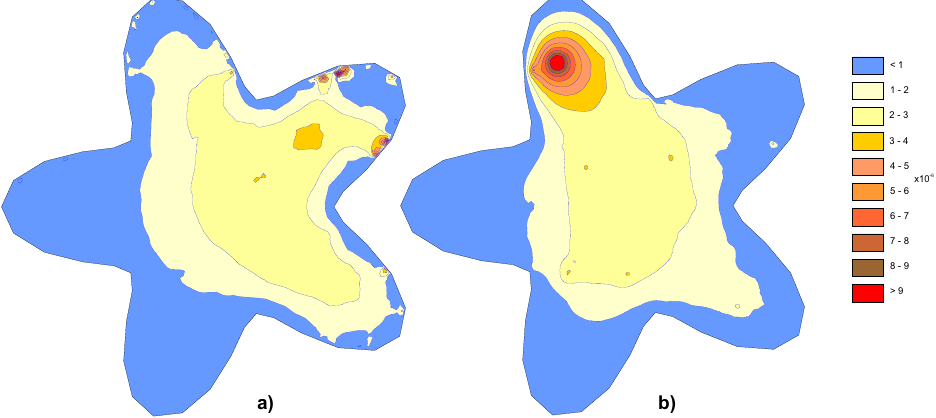
Figure 8. Example No. 2—contours of absolute errors, ( a ) 3216 points, ( b ) 6530